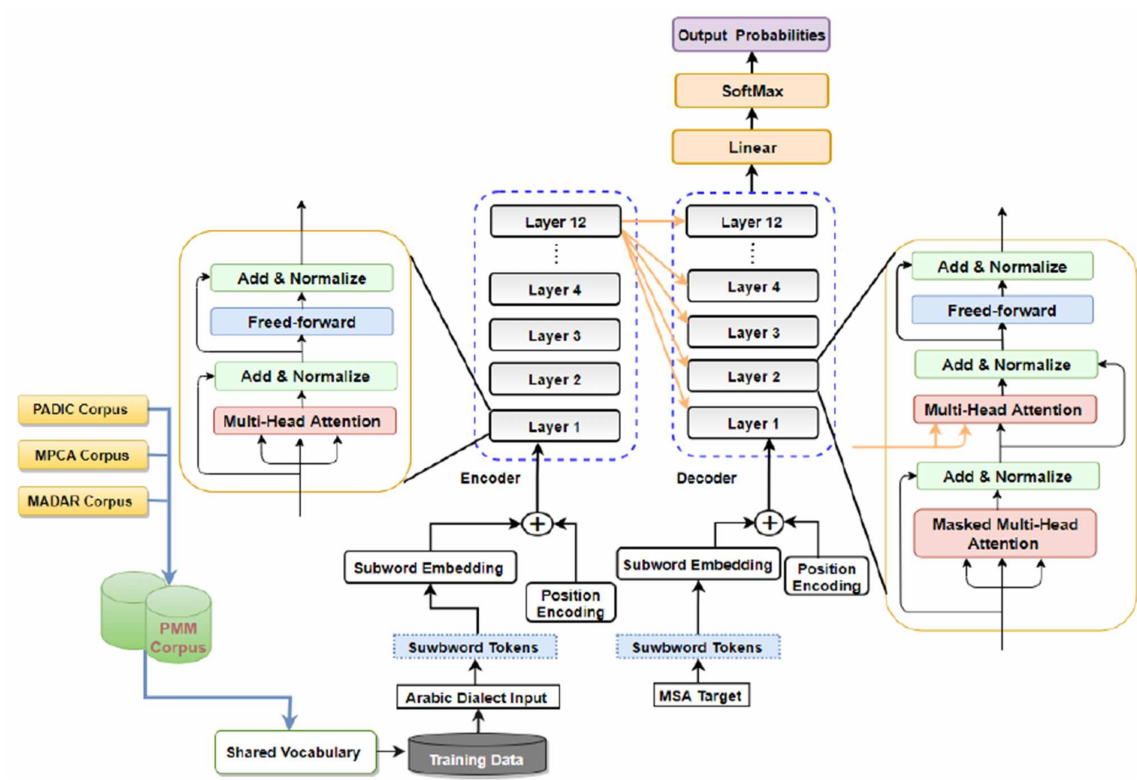
Figure 1. The Architecture of Transformer Based-Neural Machine Translation Subword Model for Arabic